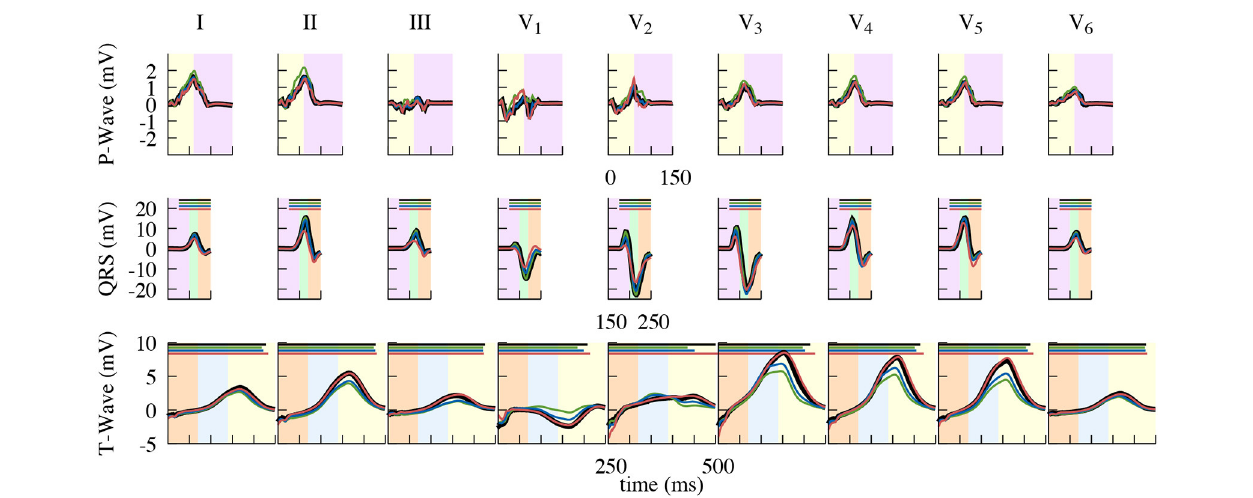
FIGURE 10 | Close up of the resulting standard lead ECG traces. Comparison of using the dynamic (black), end-diastatic (green), end-diastolic (blue), end-systolic (red) configuration to calculate different clinical ECG leads. Shown is the impact on the P-Wave (top), the QRS-Complex (middle), and the T-Wave (bottom). Background color depicting the different phases of the cardiac cycle: atrial contraction (light-purple), isovolumetric contraction (light-green), ejection (light-orange), isovolumetric relaxation (light-blue), relaxation (light-yellow). QT-Time, also shown in Table 2 , is depicted as a bar on top in the respective color.